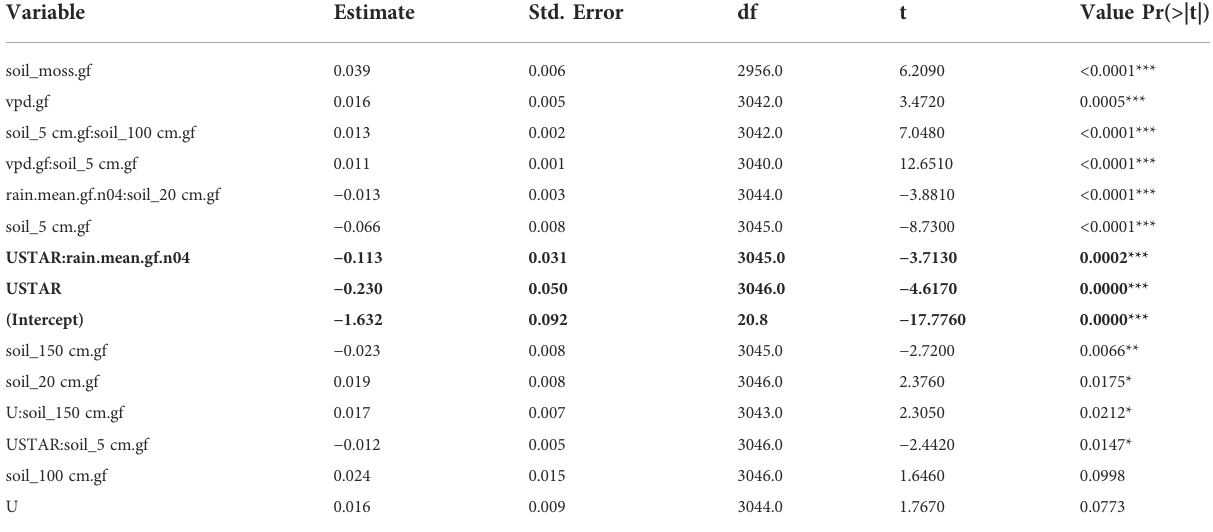
TABLE2LinearmixedeffectmodelforCH 4 fl uxduringtheTooliklakeice-freeseasons2010 – 2015.Predictorvariablesaggregatedto3-haveragesor sums (rainfall) were normalized to look at relative importance (estimate of response slopes). Insigni fi cant effects and those in fl uencing CH 4 fl ux by less than ± 1% are not included. Effects in fl uencing CH 4 fl ux by more than ± 10% are shown with bold face font. Stepwise forward selection was used to fi nd the best model. Fixed effects were sorted within each signi fi cance level according to their relative importance